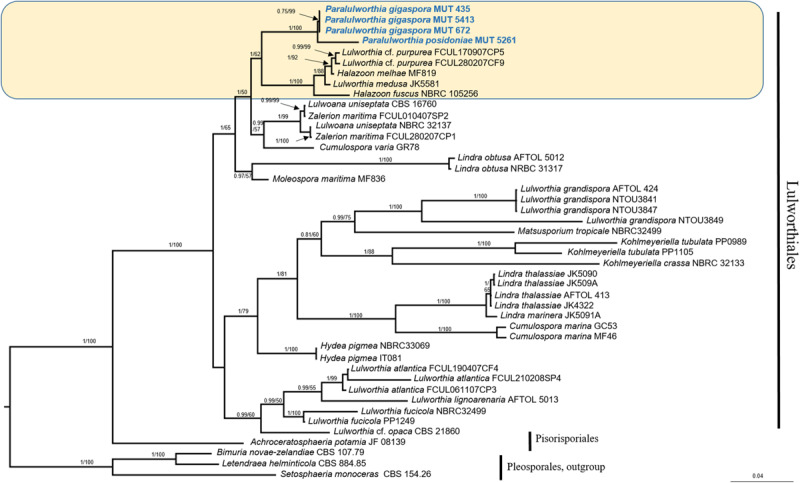
Bayesian phylogram of Lulworthiales based on a combined nrSSU, nrITS, and nrLSU dataset. The tree is rooted to Pleosporales. Branch numbers indicate BYPP/MLBvalues; Bar = expected changes per site (0.04).